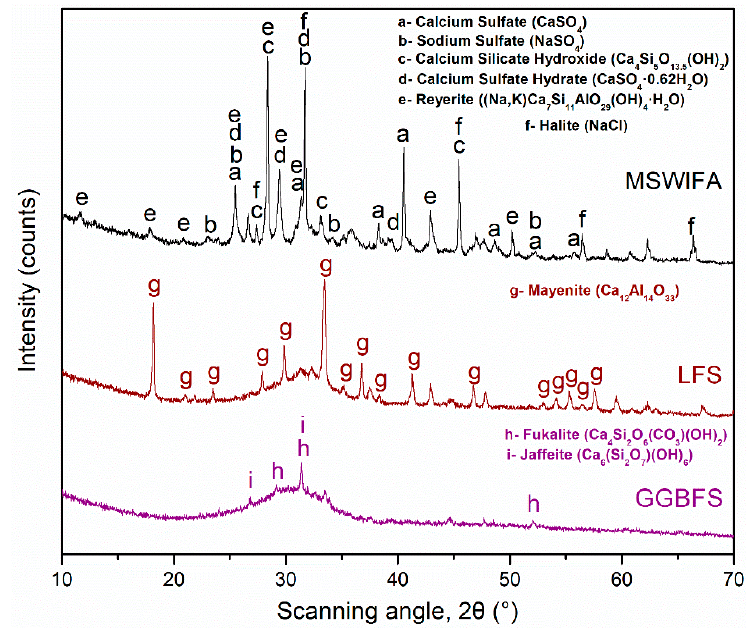
Figure 1. X-ray diffraction (XRD) spectra of municipal solid waste incineration fly ash (MSWIFA), ladle furnace slag (LFS), and ground granulated blast-furnace slag (GGBFS).